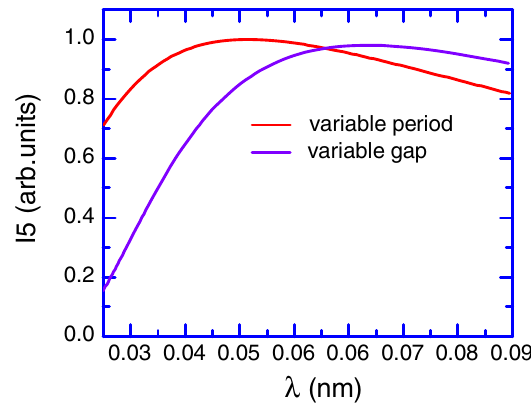
FIG. 9. The spectral intensities of the fifth